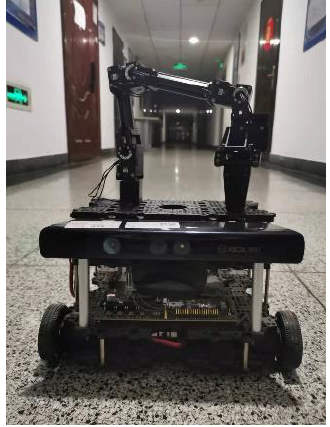
Figure 13. Turtlebot3 robot with Kinect camera.